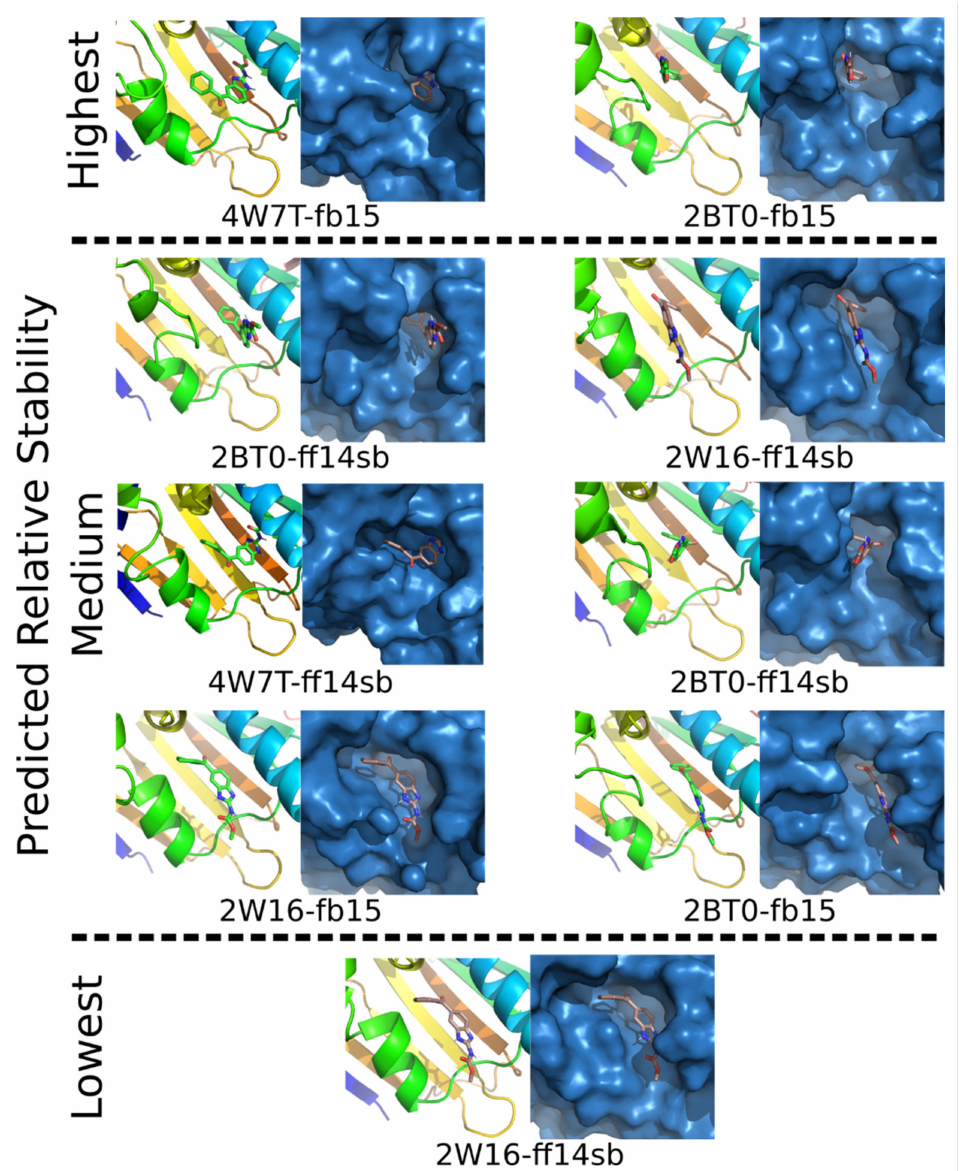
Figure 4. The nine binding poses of MBZ bound to HSP90‘s ATP binding site as identified through hierarchical clustering of the molecular dynamics simulations (600 ns in total). Each pose is shown with the protein rendered as a cartoon and surface. The poses are grouped according to the results of MM/PBSA calculations, with the highest (i.e., 0.0–0.3 kcal/mol), medium (4.6–8.9 kcal/mol) and lowest (12.6 kcal/mol) relative stabilities group together. The source of the poses are noted according to the protein crystal structure and force field used in the modeling. Only the poses identified with populations of >10% in the simulations are shown. Note that clustering a single model’s data can yield multiple